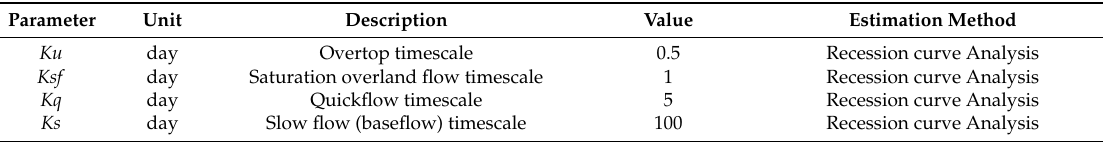
Table 1. Model parameters and